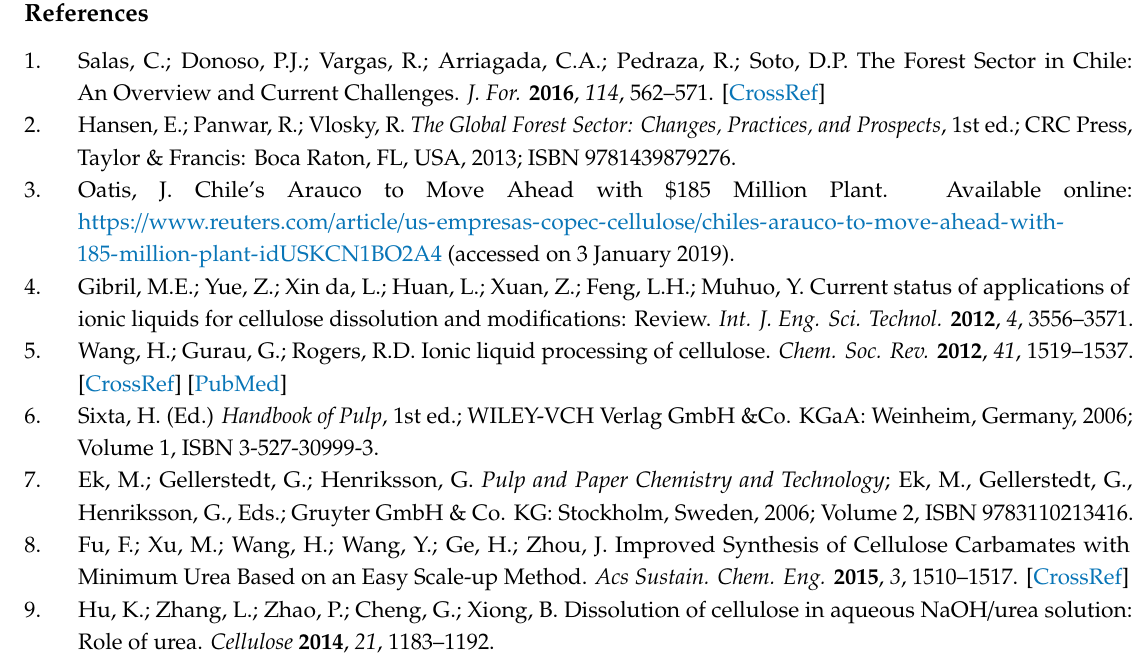
Figure S1: Total energy (U) (blue line) and total volume (V) (black line) as a function of time (t) in NPT simulation at 298.15